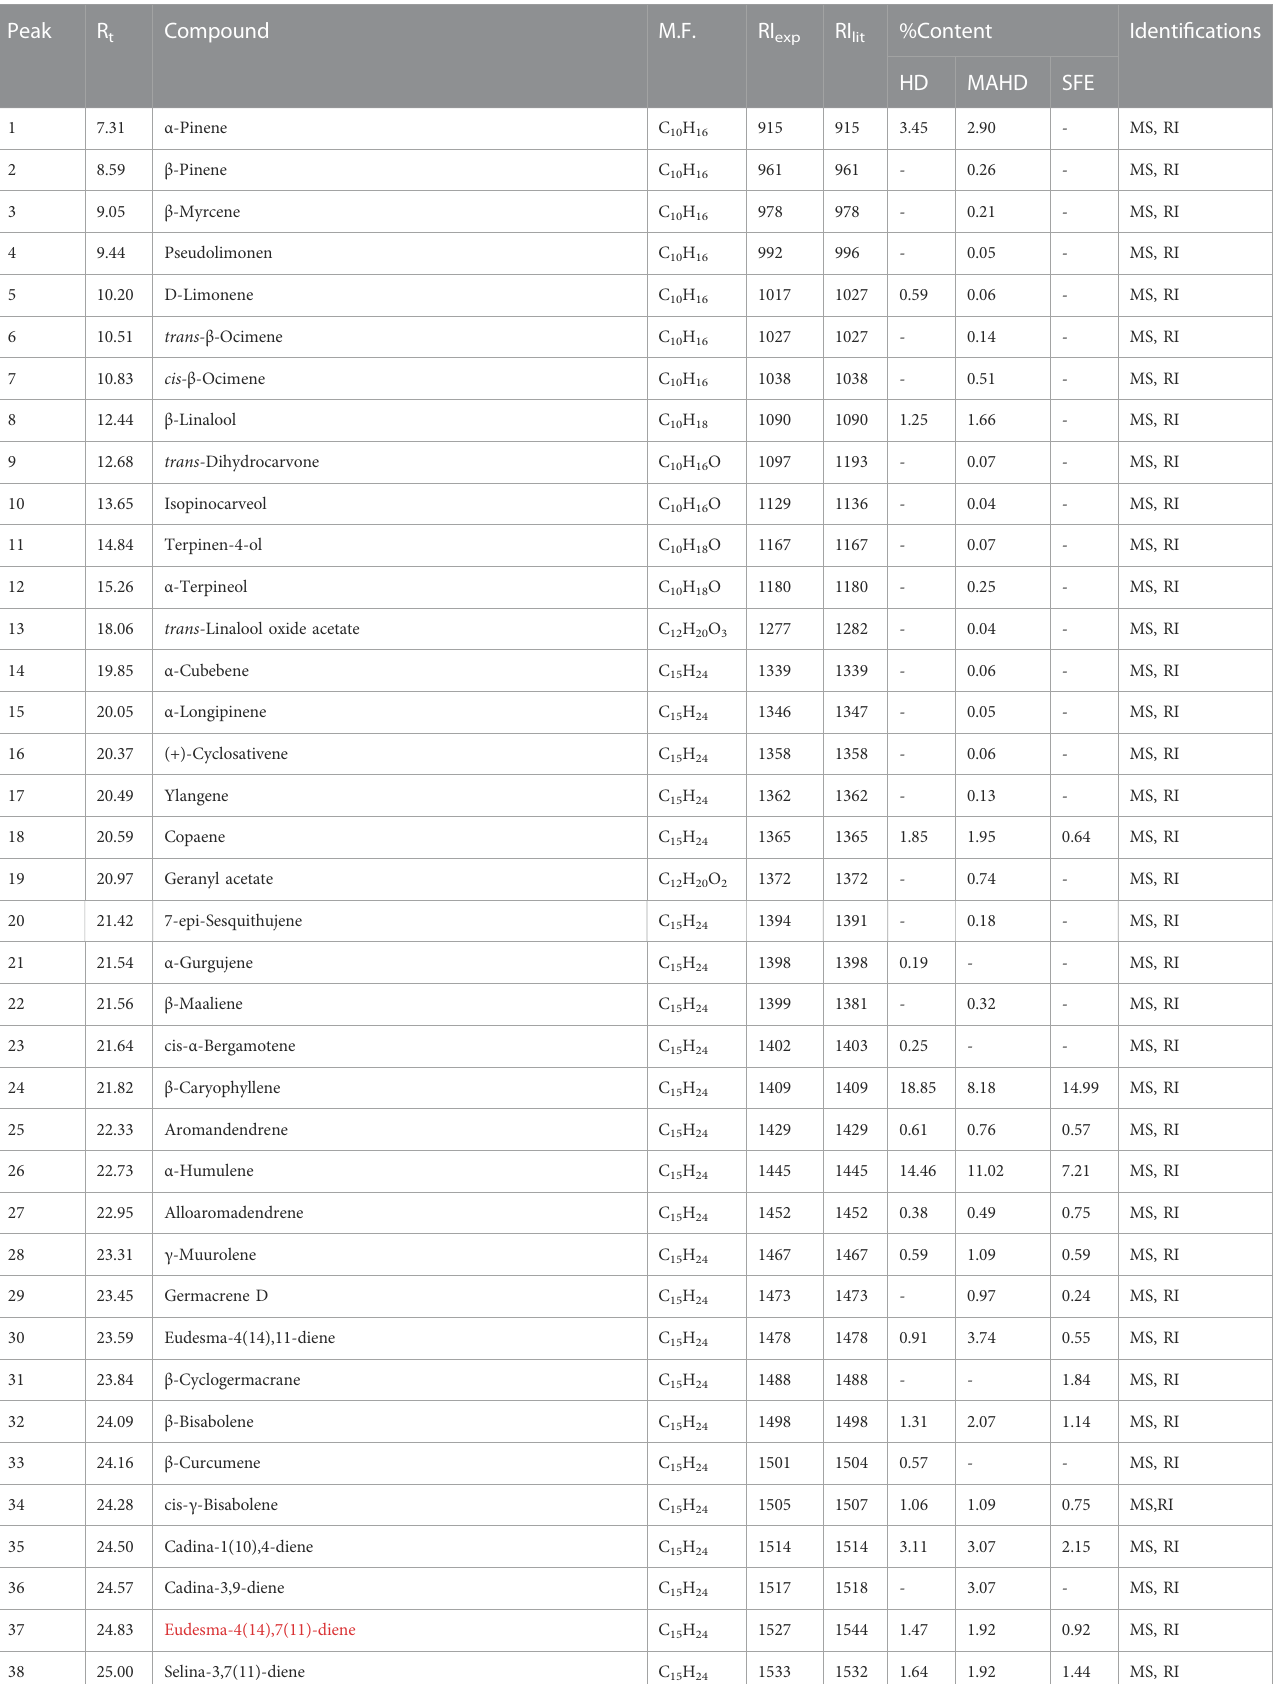
TABLE 2 Identi fi ed compounds of P . cattleianum fl owers ’ essential oil extracted by different methods. Peak R t